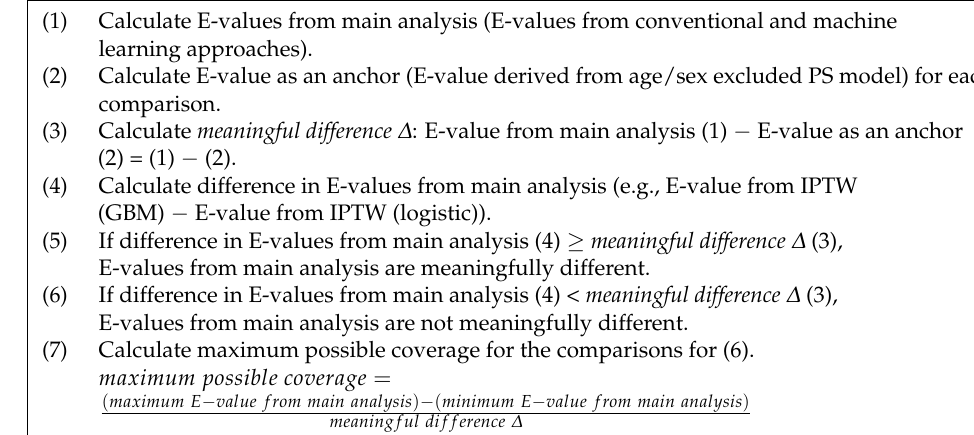
Table 1. Summarized process for comparing E-values in this